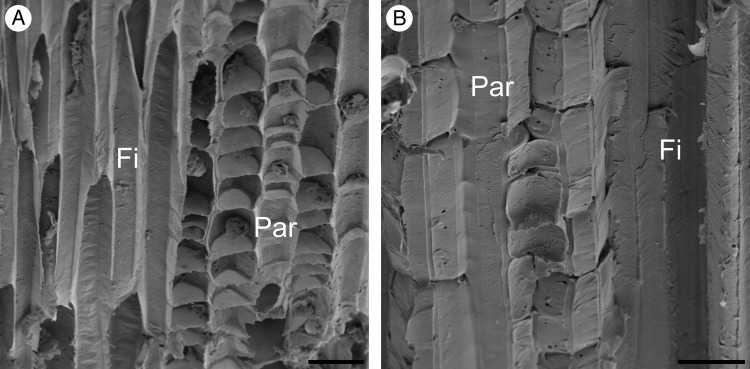
Longitudinal sections from the peripheral region of a stem of F. indica. (A) Scanning electron microscopic image of a young ontogenetic stage of the peripheral region. Between elongate fibre cells, small (∼12 µm) isodiametric cells of parenchyma are observed. (B) Scanning electron microscopic image of a mature stage from the peripheral region. Between fibrous cells, elongated (∼34 µm) parenchyma cells are visible. Par, parenchyma; Fi, fibres. Scale bars are 20 µm.